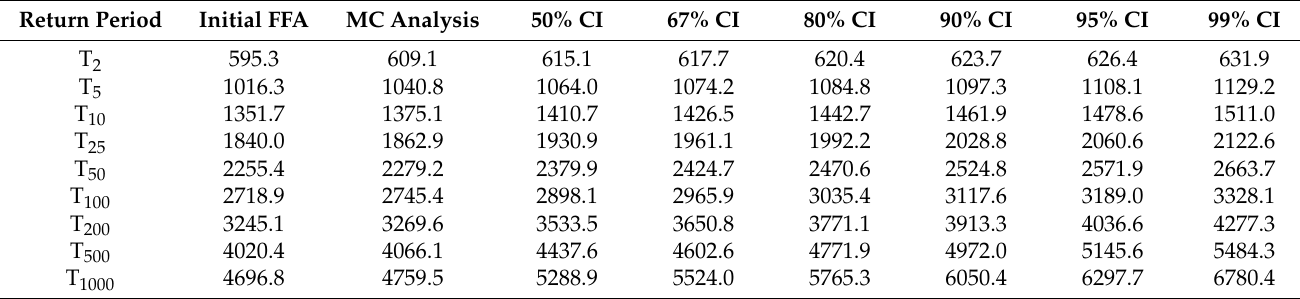
Table 1. T year peak flow values (m 3 s − 1 ) from initial FFA and further MC analysis (including upper confidence intervals—CI) in Zamora